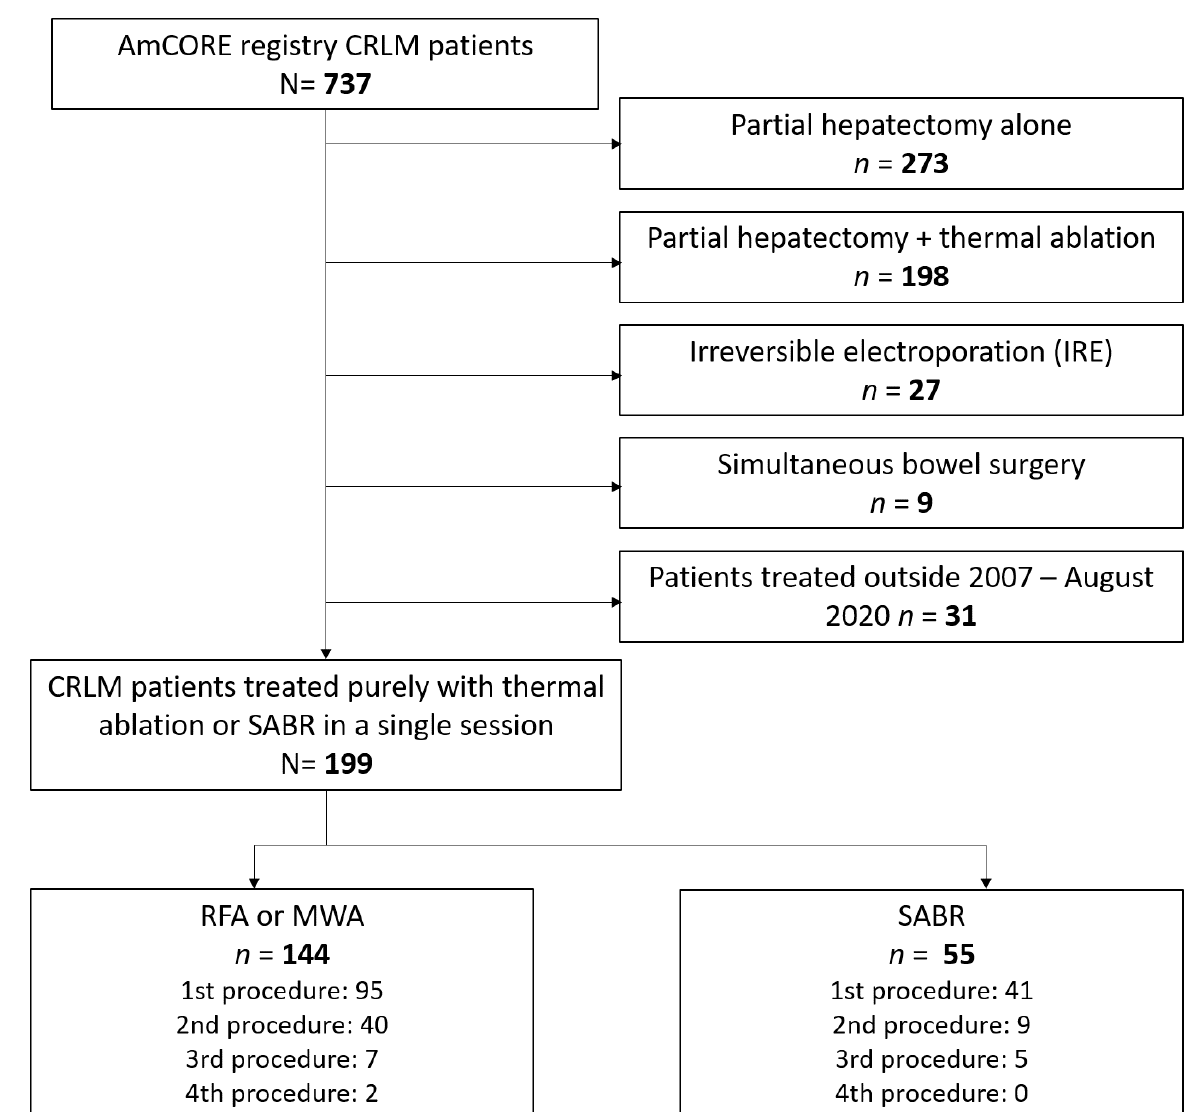
Figure 1. Flowchart of selected patients from the prospective Amsterdam Colorectal Liver Metastases Registry (AmCORE). CRLM = colorectal liver metastases, RFA = radiofrequency ablation, MWA = microwave ablation, SABR = stereotactic ablative radiotherapy.